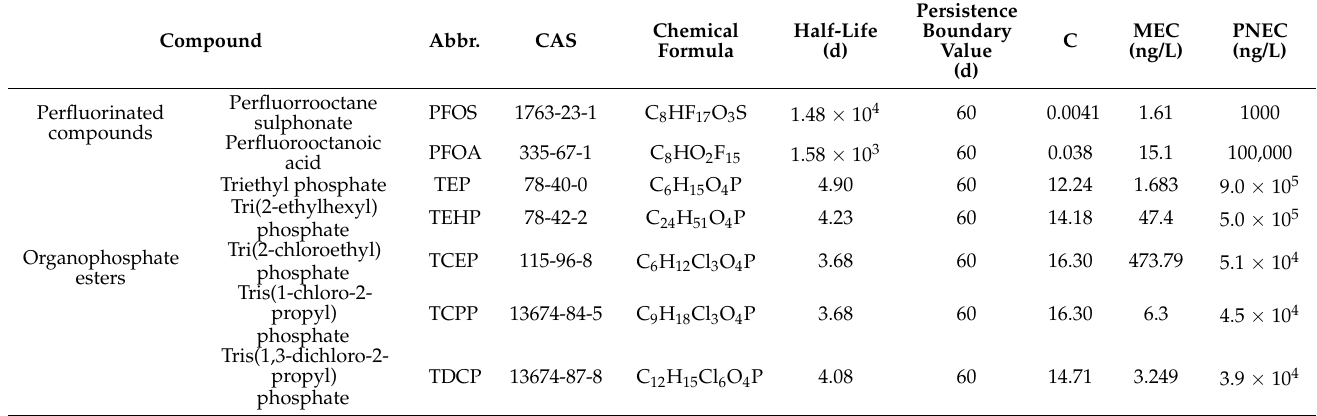
Table 2. Basic data of perfluorinated compounds in surface water of Tianjin, China, and organophos- phate esters in the Bohai Sea, China.